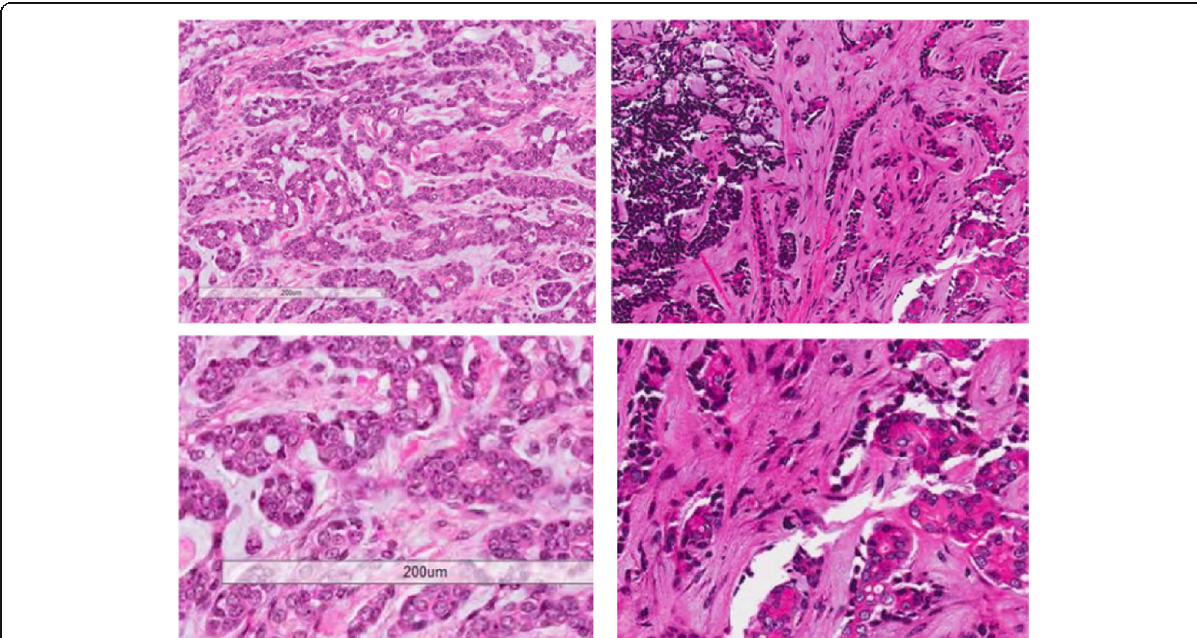
Fig. 1 Histology of Bartholin gland adenoid cystic carcinomas. Cells were found to be organized in nests, sheets, and trabeculae, with a cribriform pattern (low-power view; case 1: upper left, case 2: upper right). We also observed comparatively homogeneous cells in nests and sheets with a